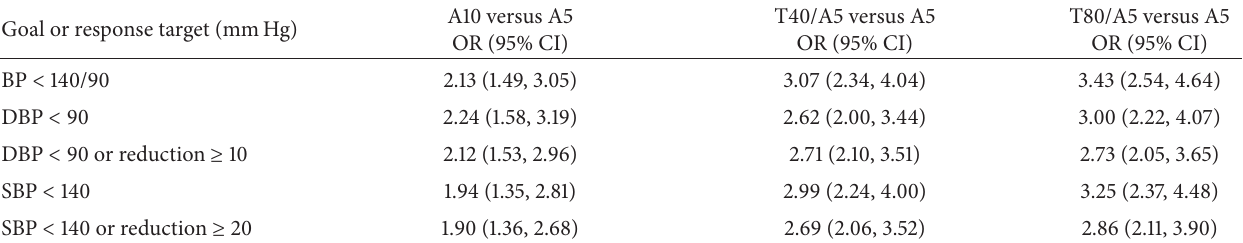
Table 3: OR for goal attainment and response rates in patients not at goal with A5 monotherapy. Goal or response target (mmHg)